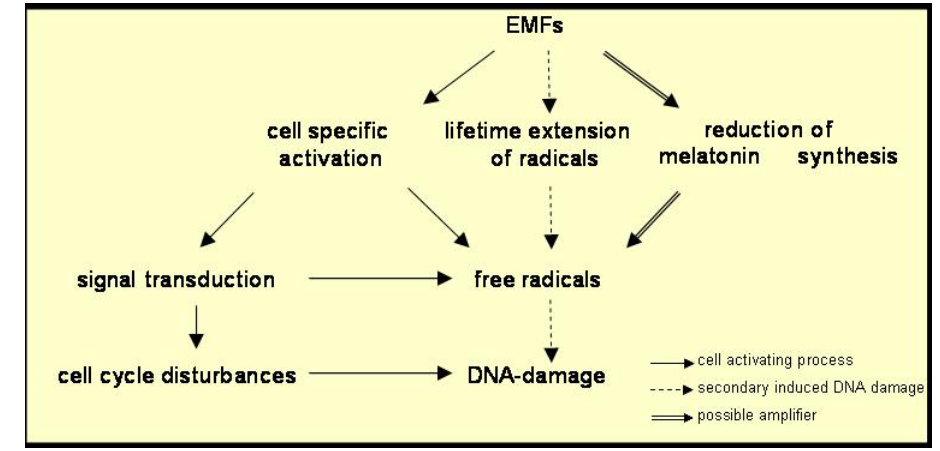
FIGURE 3. Different cellular pathways concerning free radical production after EMF exposure can lead to DNA damage. EMF exposure induces cell-specific activation processes, the induction of signal transduction